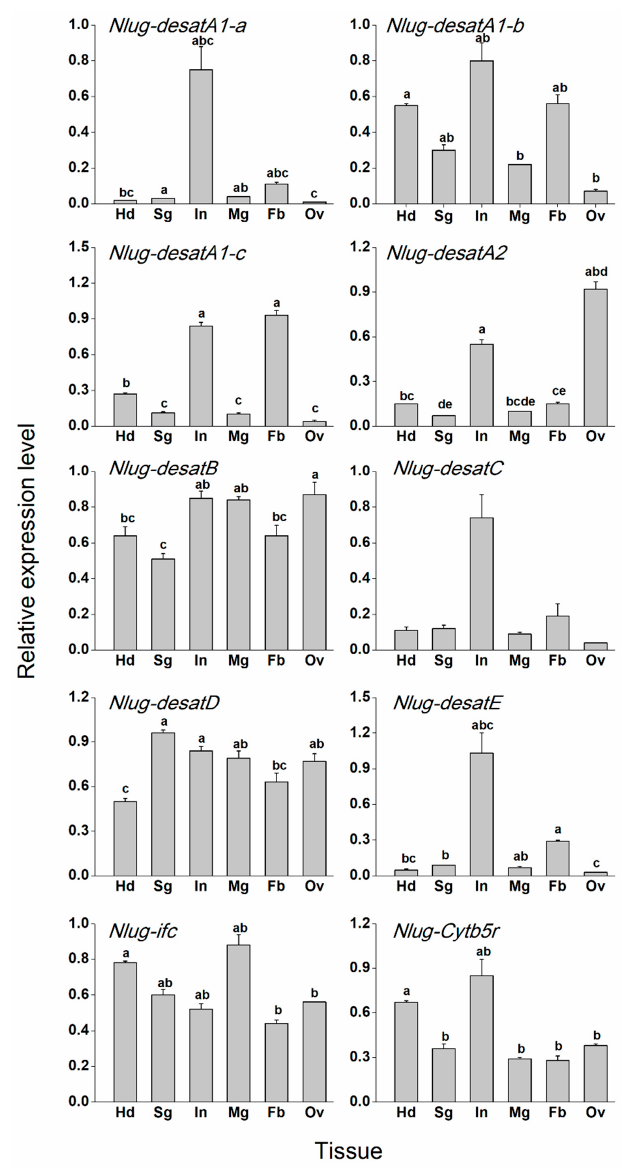
Figure 5. Mean transcript levels (+SE, n = 3) of 10 desaturase genes in different tissues of BPH. Hd, head; Sg, salivary gland; In, integument; Mg, midgut; Fb, body fat; Ov, ovary. All tissues were dissected from 4-d-old-female adults. The results (threshold cycle values) of the qRT-PCR assays were normalized to the expression level of RPS11 (ribosomal protein S11, GenBank accession number: ACN79505.1). Letters indicate significant differences among different treatments ( p < 0.05). Statistical information is provided in Table S4 and Table